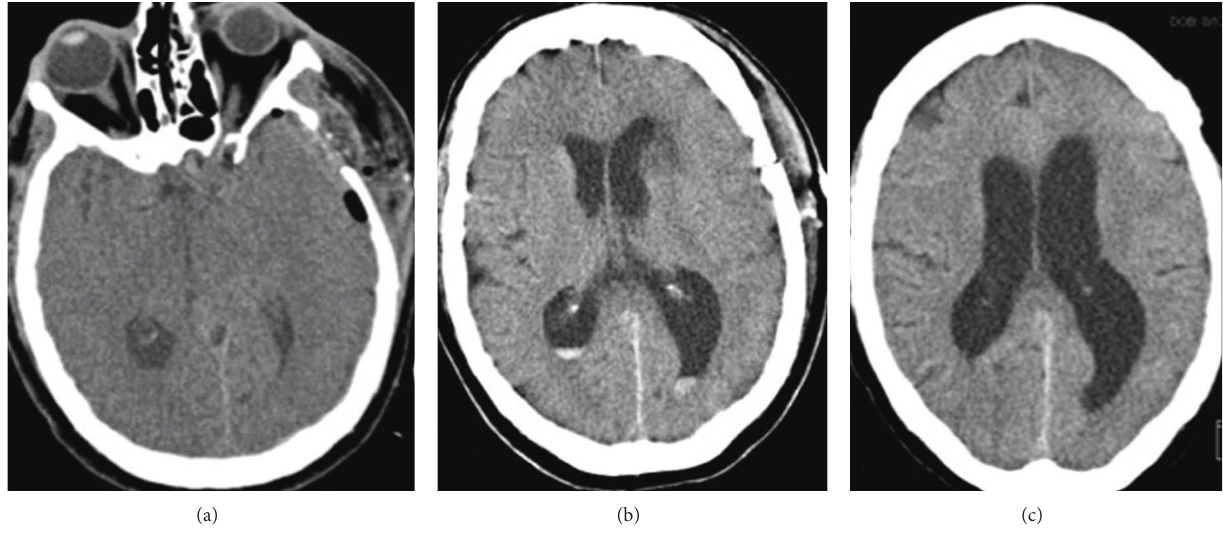
Figure 1: (a) Noncontrast axial computed tomography scan of the head done on postoperative day 5 showing some postoperative changes after a left frontotemporal craniotomy for resection of the patient’s recurrent planum sphenoidale meningioma. The scan did not show any intraventricular hemorrhage; however, it showed unilateral enlargement of the left lateral ventricle. (b) Noncontrast axial computed tomography scan of the head done one day after the epidural blood patch showing a new-onset hemorrhage layering the occipital horns of both lateral ventricles. (c) Noncontrast axial head computed tomography scan done two weeks later showing complete resolution of the intraventricular hemorrhage.